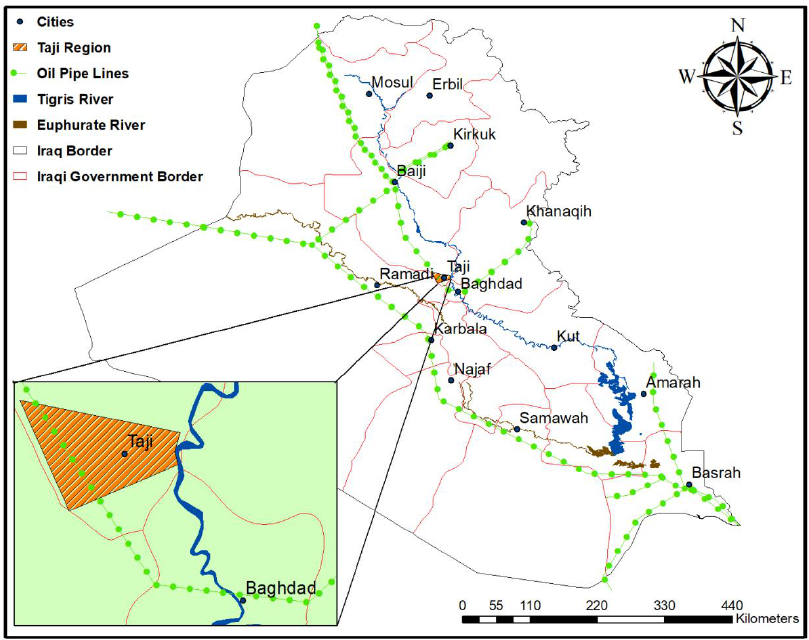
Figure 2. The location of the study area (Taji region) and crude oil pipelines in Iraq. Table 2. Physical characteristics of soils used for the JETs.